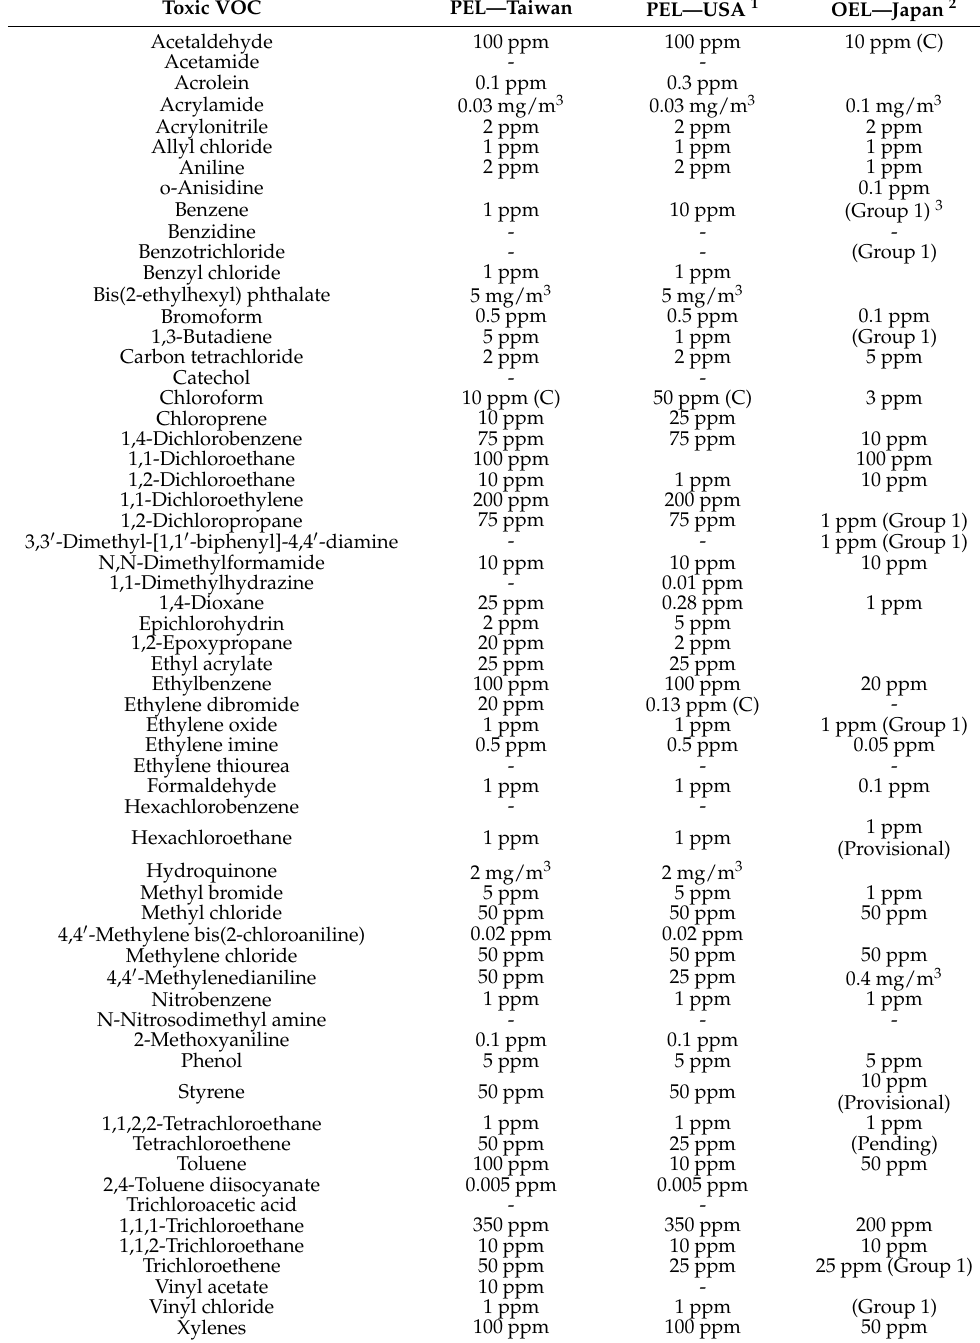
Table 3. Permissible exposure limits (PELs)/occupational exposure limits (OELs) of toxic VOCs in Taiwan, the USA, and